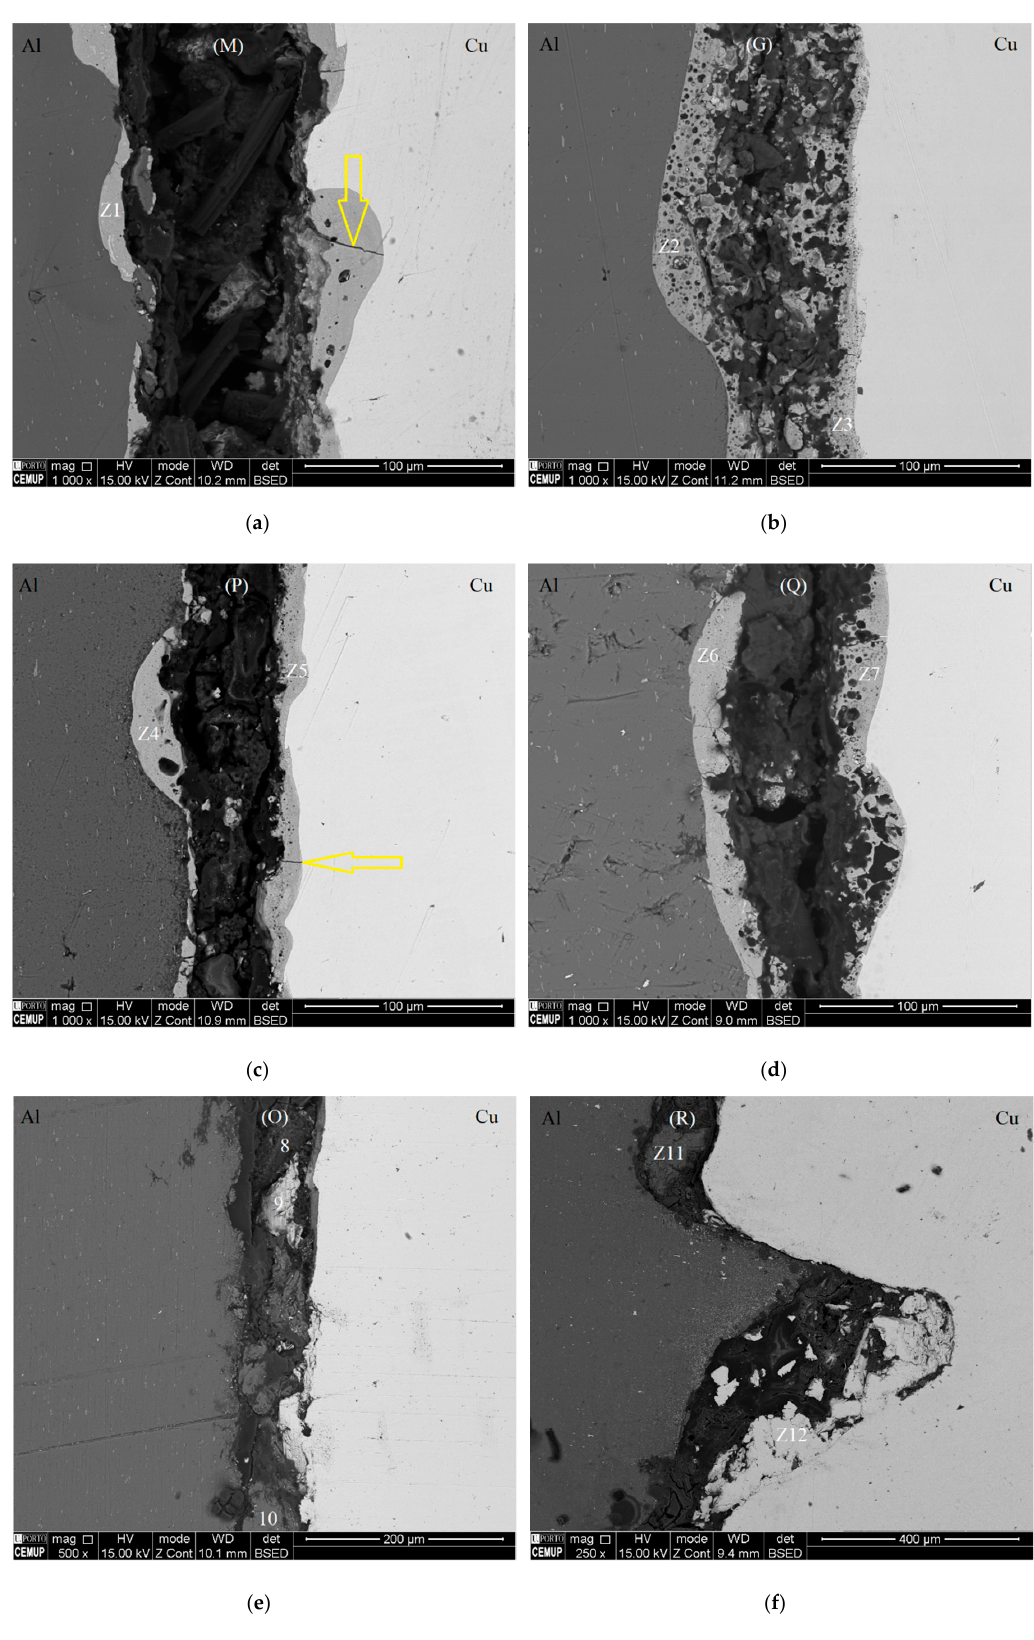
Figure 5. SEM/BSE images used for the chemical analysis of the interested zones at the interfaces of the ( a ) Al/Cu-M, ( b ) Al/Cu-G, ( c ) Al/Cu-P, ( d ) Al/Cu-Q, ( e ) Al/Cu-O, and ( f ) Al/Cu-R joints produced by MPW technique. Table 7. The SEM/EDS results obtained from the zones of interest indicated in the images in Figure 5. Zone Al (at.%) Cu (at.%) Others (at.%)